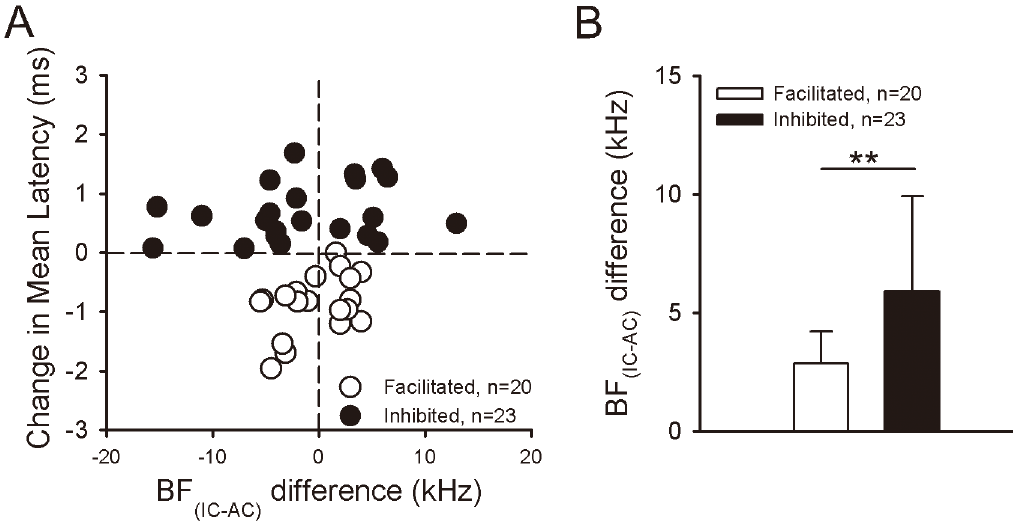
Fig 9. Relation between latency change of IC neurons and the BF IC-AC difference. (A) Scatter plots showingthe changein latenciesof facilitated(unfilledcircle) and inhibited(filled circle) IC neuronsagainstthe BF IC-AC difference. (B) Comparison of BF IC-AC difference for corticofugally facilitated(unfilledcolumn) and inhibited(filled column)IC neurons, showinga statistically significantdifference ( ** , p < 0.01) betweentwo mean values.